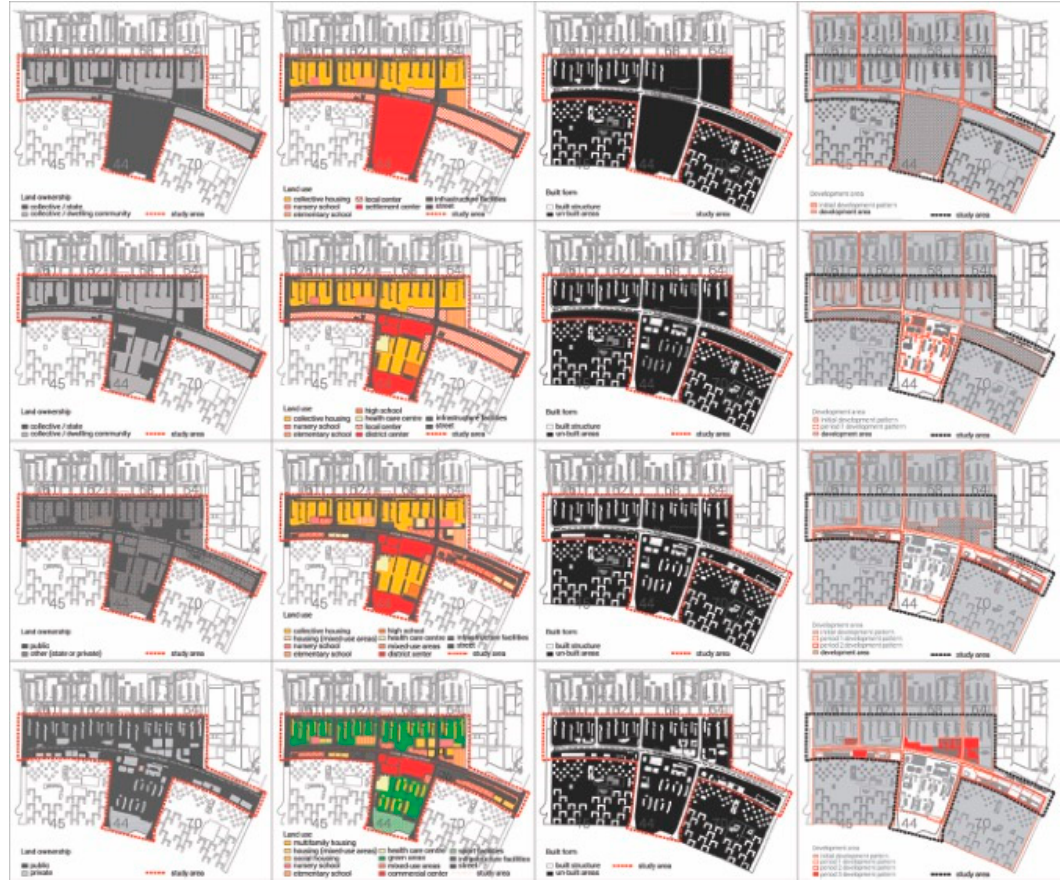
Figure 7. Transition of collective land: causes and means of fragmentation of the morphology of the superblock (source: authors).